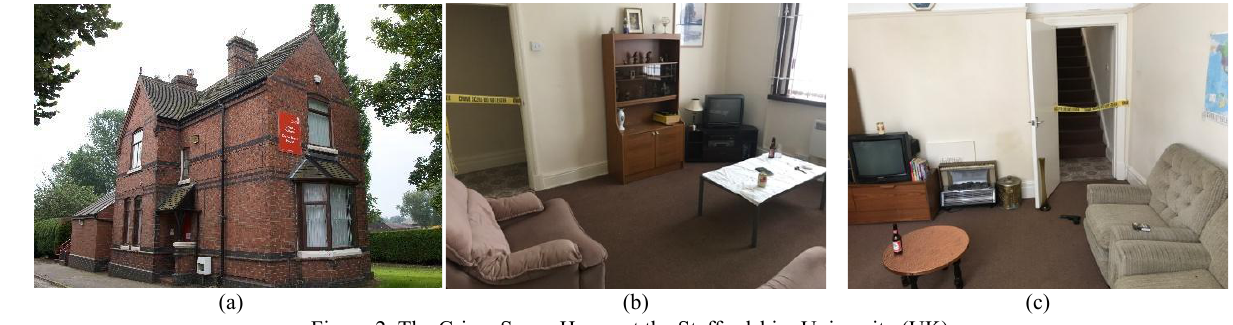
Figure 2. The Crime Scene House at the Staffordshire University (UK): an overview of the building (a) and two views of the interior rooms (b and c).